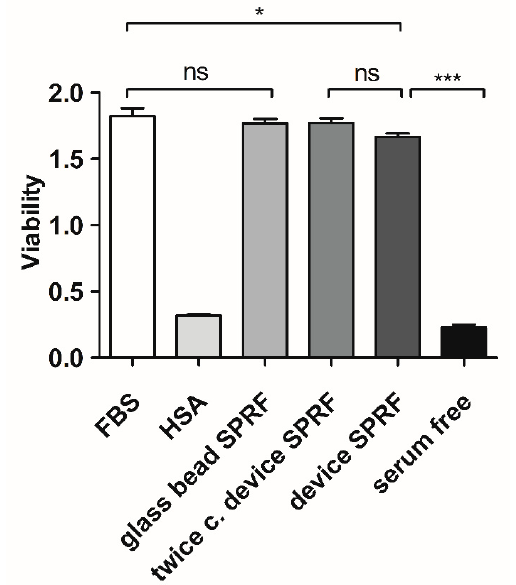
Figure 3. Viability of cells cultured in different serum-containing media. There is no significant difference between SPRF containing media regarding mesenchymal stem cells (MSC) viability. The significance level was p < 0.05, where * means that the p -value was between 0.05 and 0.01, ** means that the p -value was between 0.01 and 0.001, and *** means that p -value was lower than 0.001.